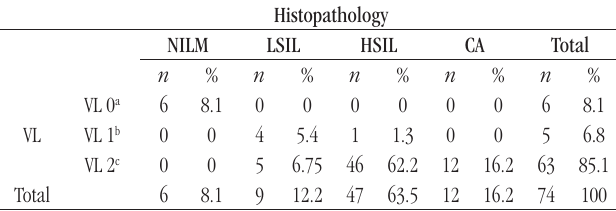
taBLE 1 − Distribution of histopathological findings according to the viral load Histopathology